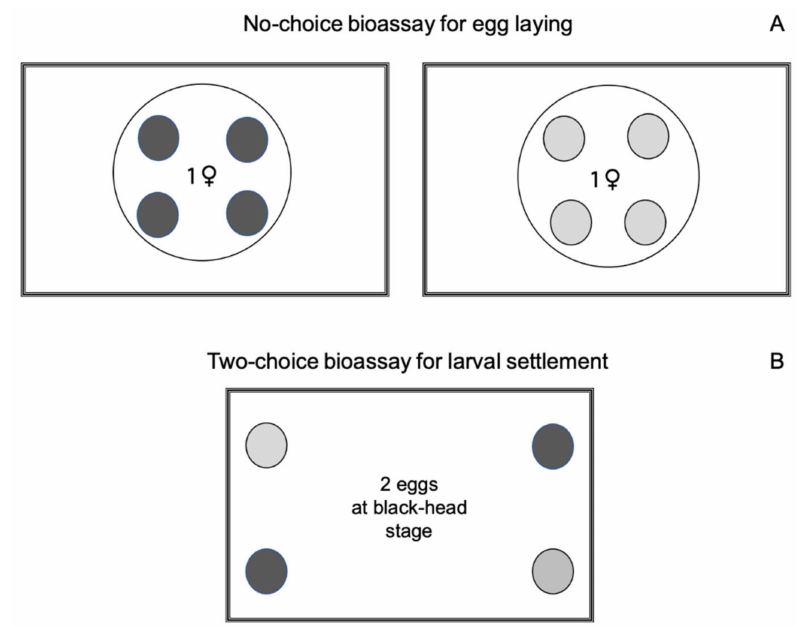
Figure 1. Schemes of laboratory bioassays carried out with sulfur dust on Lobesia botrana , as described in Section 2.1.3 ( A ) and Section 2.1.5 ( B ). Rectangle = polystyrene box; large circle = glass Petri dish; dark gray circles = control berries; light gray circles = sulfur-dust-covered